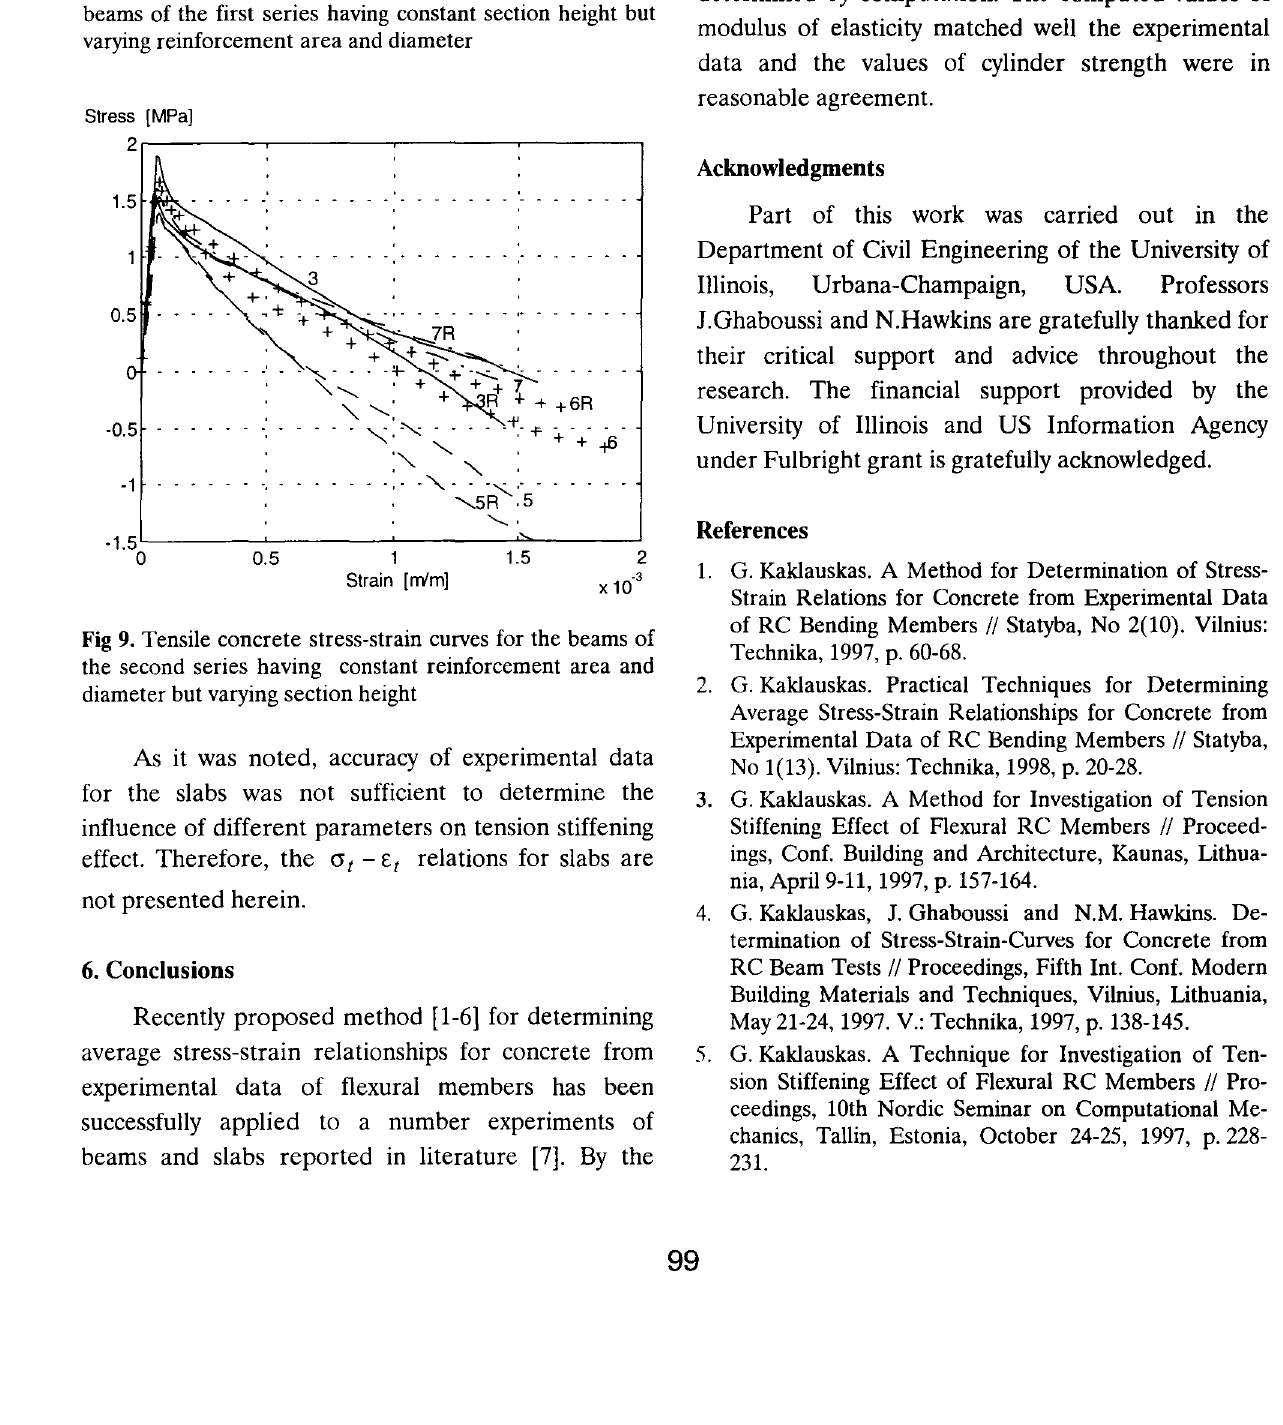
Fig 8. Tensile concrete stress-strain relationships for the beams of the first series having constant section height but varying reinforcement area and diameter